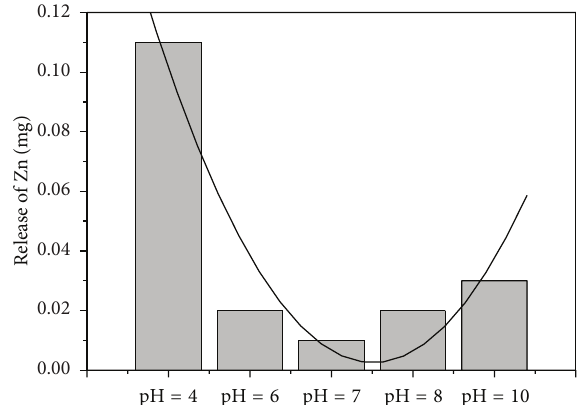
Figure 2: The relationship between the maximum amount of accumulated Zn release from sediment in experimental period and